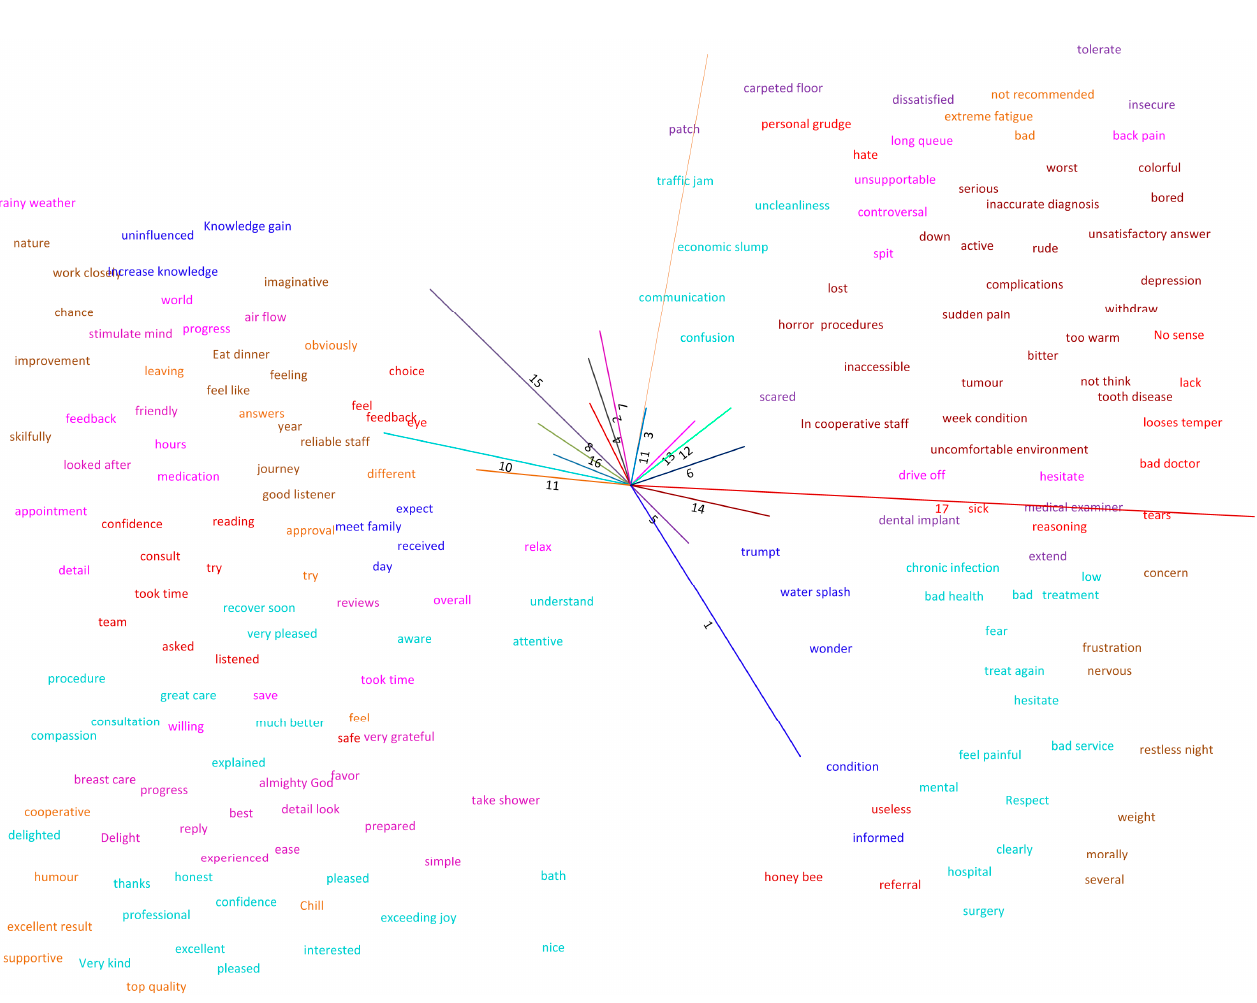
Figure 3. Affective space.